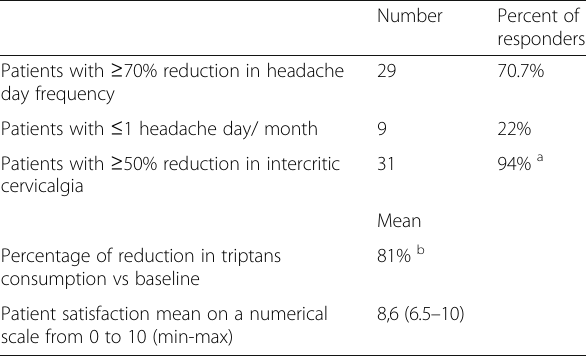
Table 2 Secondary outcome